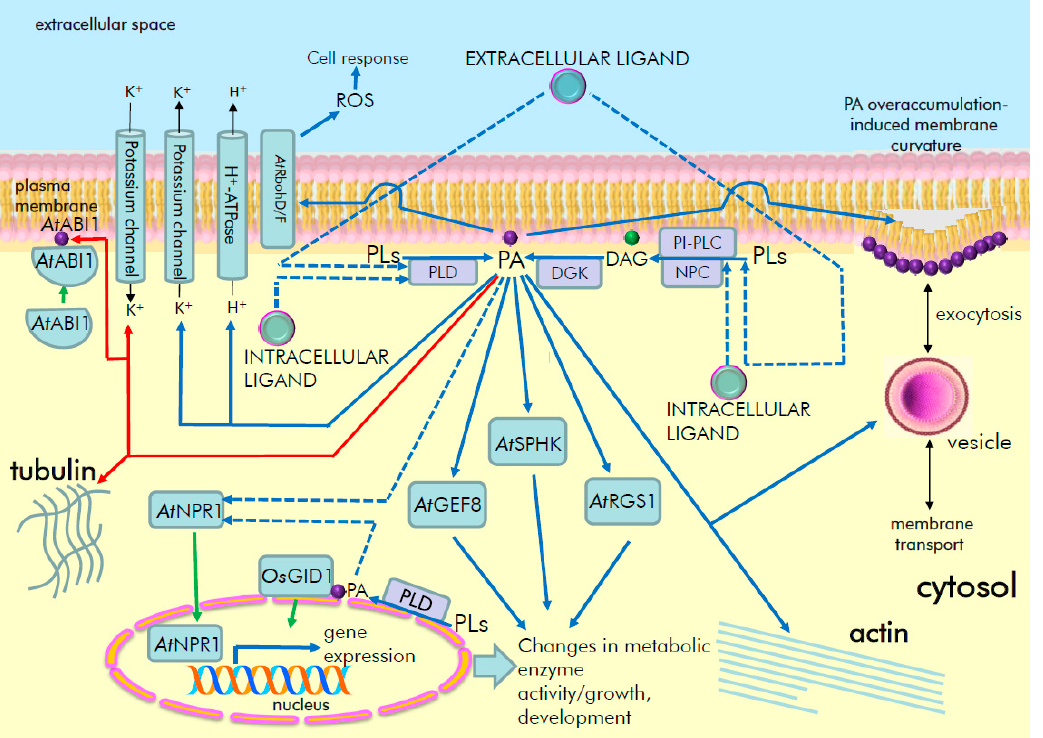
Figure 4. Schematic representation of the PA signaling in plants. Hypothetical receptors lead to activation of lipid signaling enzymes. Key examples of PA-regulated signaling events in hormonal regulation are shown (for details, see the main text); also shown here are PA-induced changes of membrane curvature and subsequent membrane transport events. Headgroups of DAG in a membrane are shown in green; headgroups of PA in crimson; and headgroups of other lipids in pink color. ABI1, ABSCISIC ACID-INSENSITIVE 1, At , Arabidopsis thaliana , DAG, diacylglycerol, DGK, diacylglyc- erol kinase, GEF8, RopGEF8, guanine nucleotide exchange factor 8, GID, GIBBERELLIN INSENSITIVE DWARF1, NPC, non-specific phospholipase C, NPR1, NONEXPRESSOR OF PATHOGENESIS-RELATED GENES 1, Os , Oryza sativa , PA, phosphatidic acid, PI-PLC, phosphatidylinositol-specific phospholipase C; PLD, phospholipase D, PLs, phospholipids (e.g., phosphatidylcholine, phos- phatidylethanolamine), RbohD/F, respiratory burst oxidase protein D/F, RGS1, Regulator of G protein Signaling 1, ROS, reactive oxygen species, SPHK, sphingosine